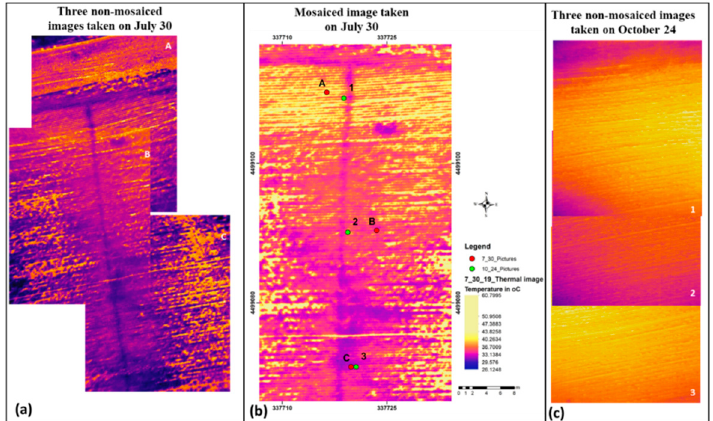
Figure 8. ( a ) Non-mosaiced thermal images, date collected: 30 July 2019 ( b ) mosaiced thermal images, collected on 30 July 2019 and ( c ) not mosaiced thermal images from 24 October 2019 (note: difficulty mosaicking the images collected on this date due to large temperature variability).